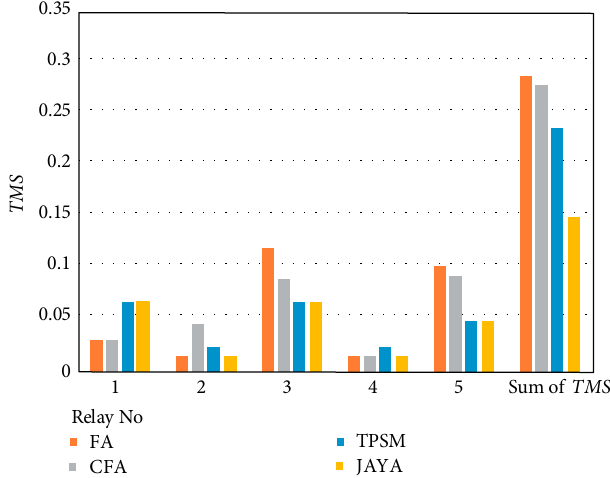
Figure 11: Comparison of the graphical representation of optimal TMS with FA, CFA, and TPSM algorithm for Case 3. Table 15: Comparison of the total net time gain achieved by the proposed method for Case 3.